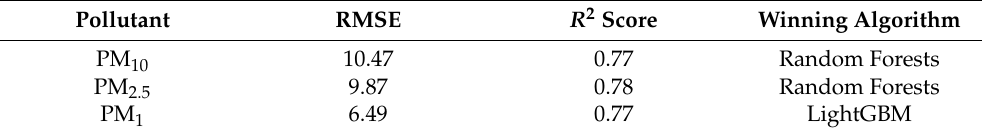
Table 1. Results of the machine learning models for PM-concentrations shown on the validation set (MVS). Pollutant